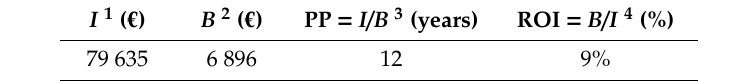
Table 18. Payback period and rate of return as a benefit of reducing municipal rainwater